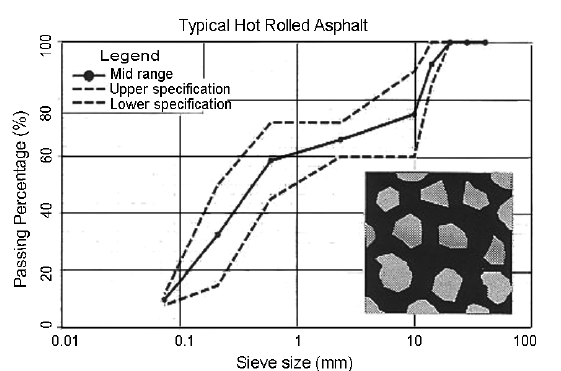
Fig. 1. A typical grading and cross section of a HRA30/14